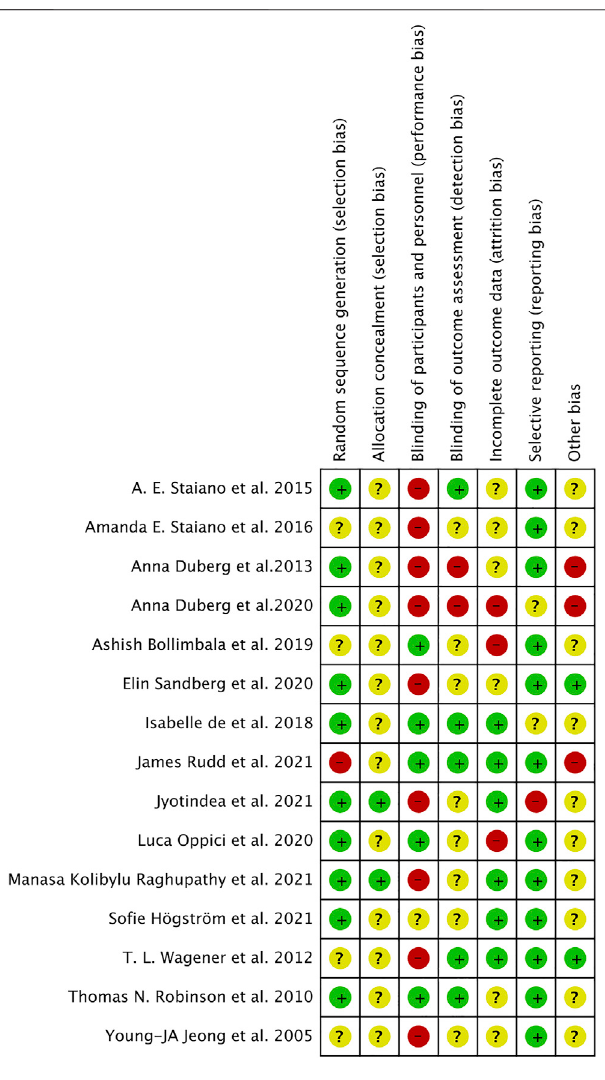
FIGURE 3 | Risk of bias for each